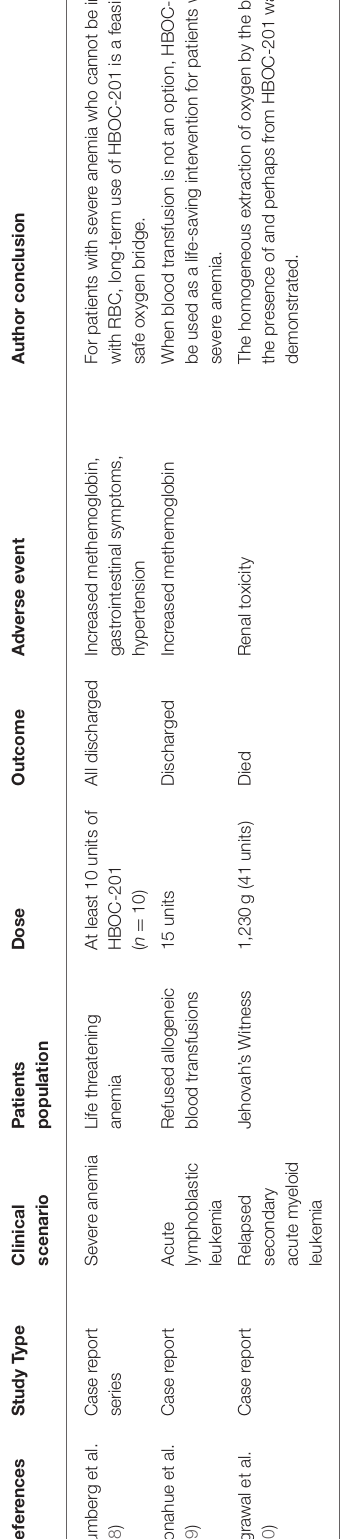
TABLE 3 | Overview of the characteristics of HBOC-201 and human red blood cells.